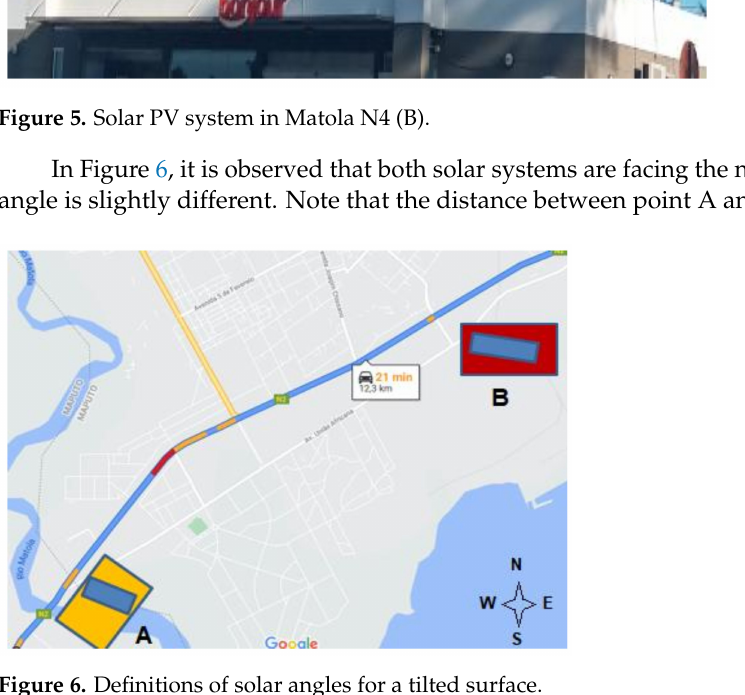
Figure 6. Definitions of solar angles for a tilted surface.